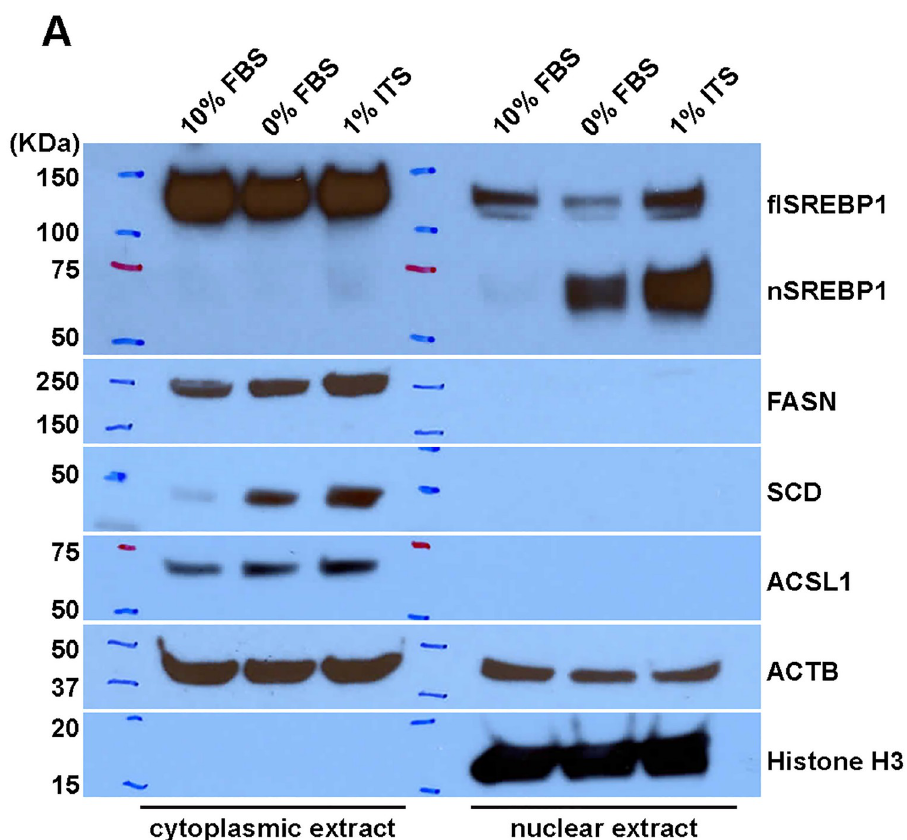
Fig 5. Lipid depletion combined with insulin supplement yields increased expression of nuclear SREBP1. (A) The cytoplasmic and nuclear fractions of HT-144 cells cultured in 10%, 0% FBS or 1% ITS medium were isolated for Western blot analysis. HT-144 cells in 1% ITS medium have increased levels of nuclear SREBP1 protein and lipogenic enzymes, detected with the indicated antibodies. Histone H3 serves as the positive control for nuclear fractionation during biochemical preparation of the cell